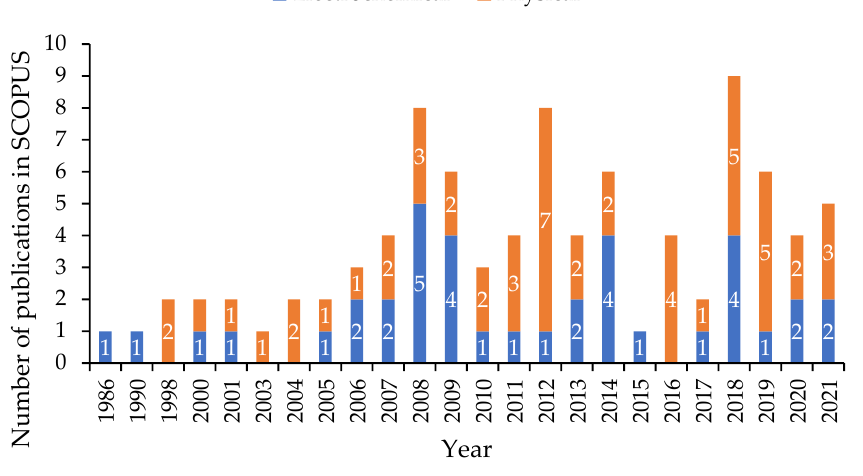
Figure 4. Distribution of publications over time (1986 – 2021) from the SCOPUS database.